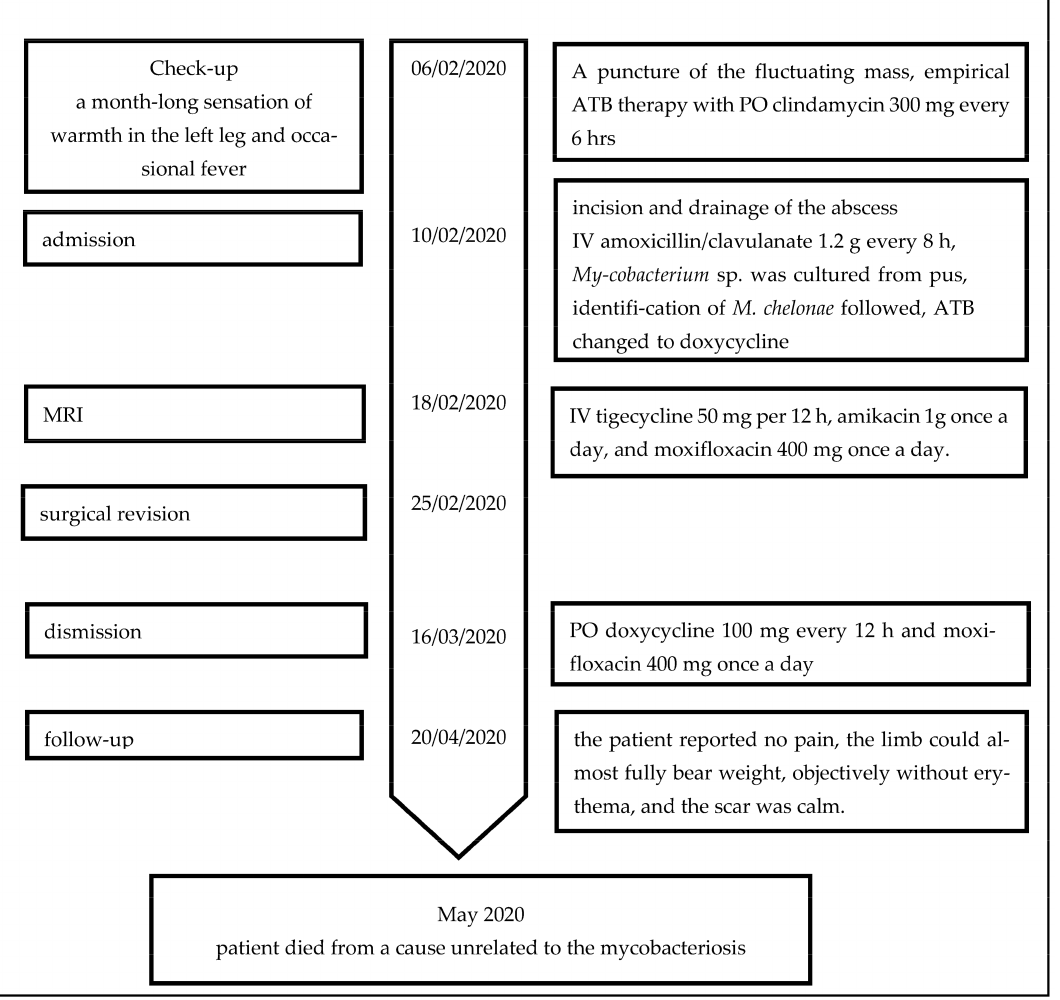
Figure 4. The timeline of the